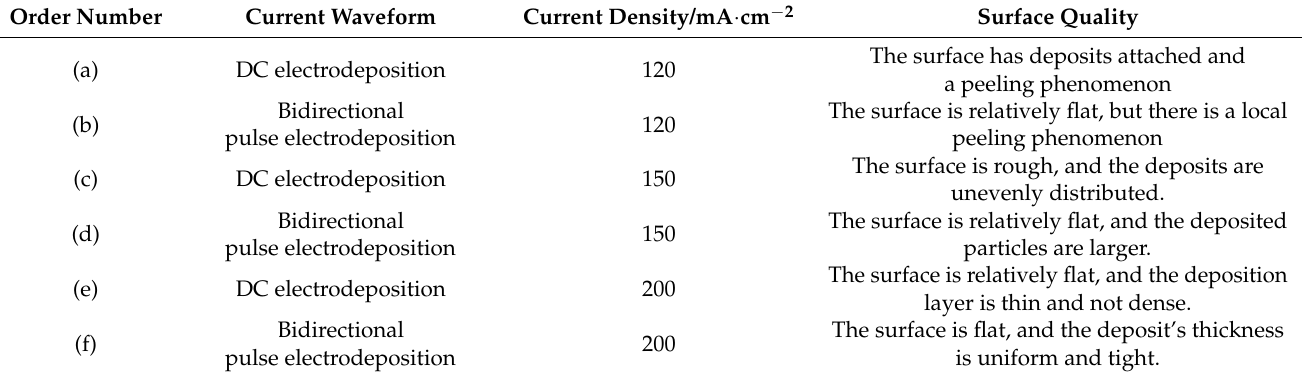
Table 2. Surface quality of deposition layers at different current waveforms and current